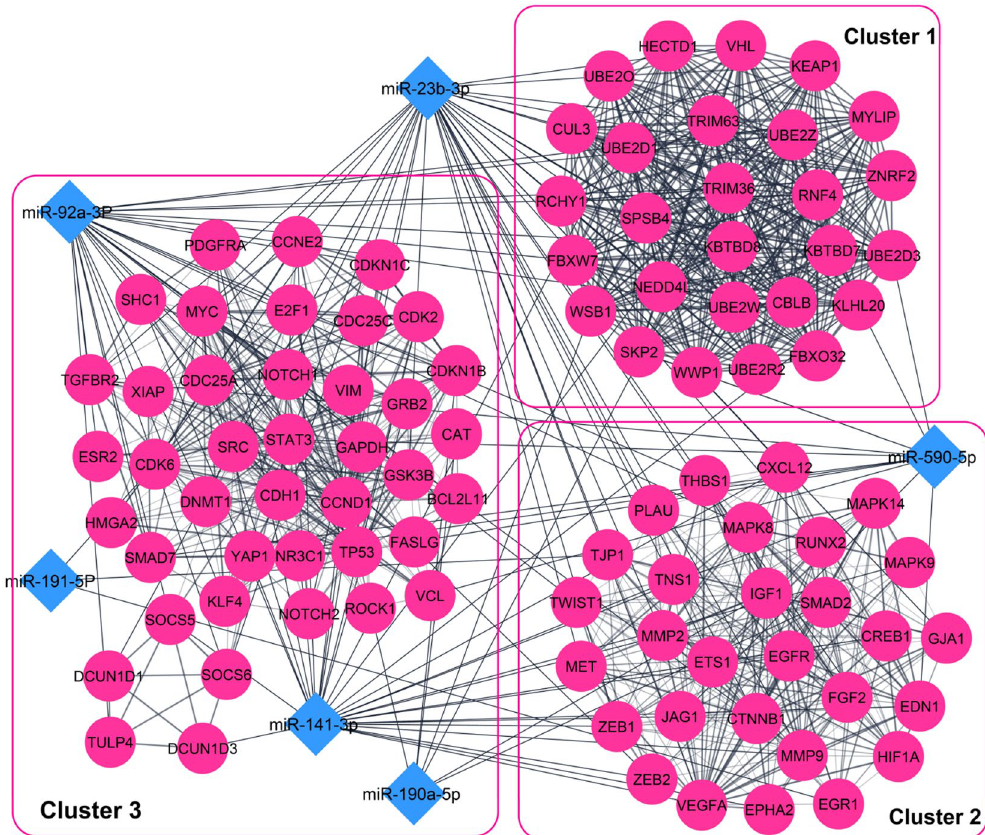
Figure 5. The three top modules extracted from the PPI network and their associations with the six miRNA biomarkers. The pink circles show the validated and predicted target genes. Blue diamonds indicate the six final miRNA